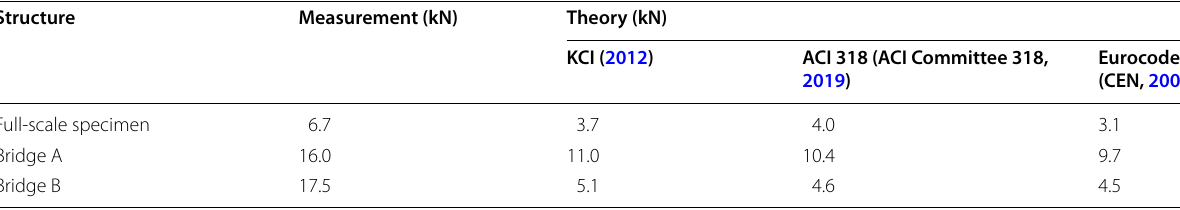
Table 8 Change in elastic shortening loss at mid‑span according to the modulus of elasticity of